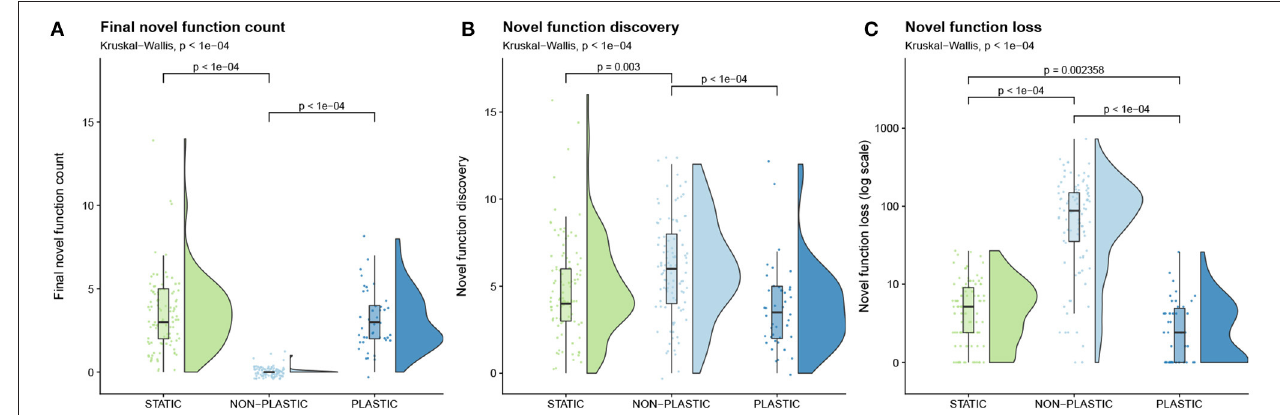
FIGURE 6 | Novel function evolution. Raincloud plots of (A) final novel function count, (B) novel function discovery, and (C) novel function loss. See Table 1 for descriptions of each metric. Each plot is annotated with statistically significant comparisons (Bonferroni-corrected pairwise Wilcoxon rank-sum tests). Note that adaptive phenotypic plasticity evolved in 42 of 100 replicates from the PLASTIC treatment during phase one of this experiment; we used this more limited group to seed the resulting 42 phase-two PLASTIC